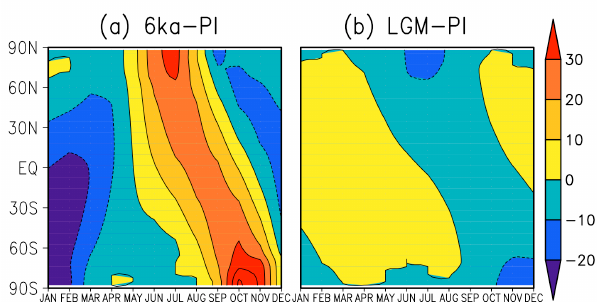
Fig. 6. The change in incoming shortwave radiation (Wm − 2 ) at the top of the atmosphere for (a) 6ka PI and (b) Figure 6. The change in incoming short wave radiation (W/m 2 ) at the top of the atmosphere 4 for (a) 6ka-PI and (b) LGM-PI. 5